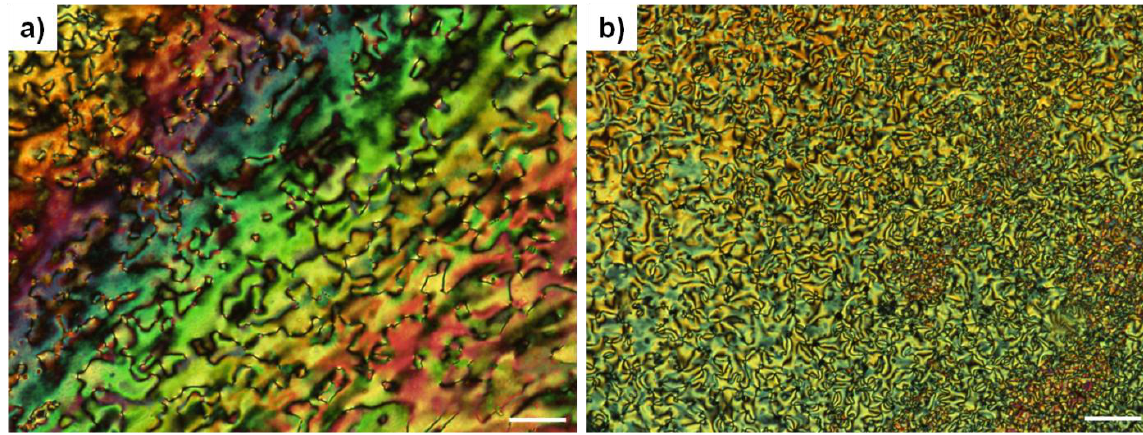
Figure 3. Polarizing optical micrographs: ( a ) compound 7 exhibiting a typical nematic Schlieren texture at 71 °C; ( b ) compound 10 showing a blurred Schlieren texture at 50 °C, indicating a smectic C phase. Samples were sandwiched between glass slides and viewed through crossed polarizers. (Scale bar: 50